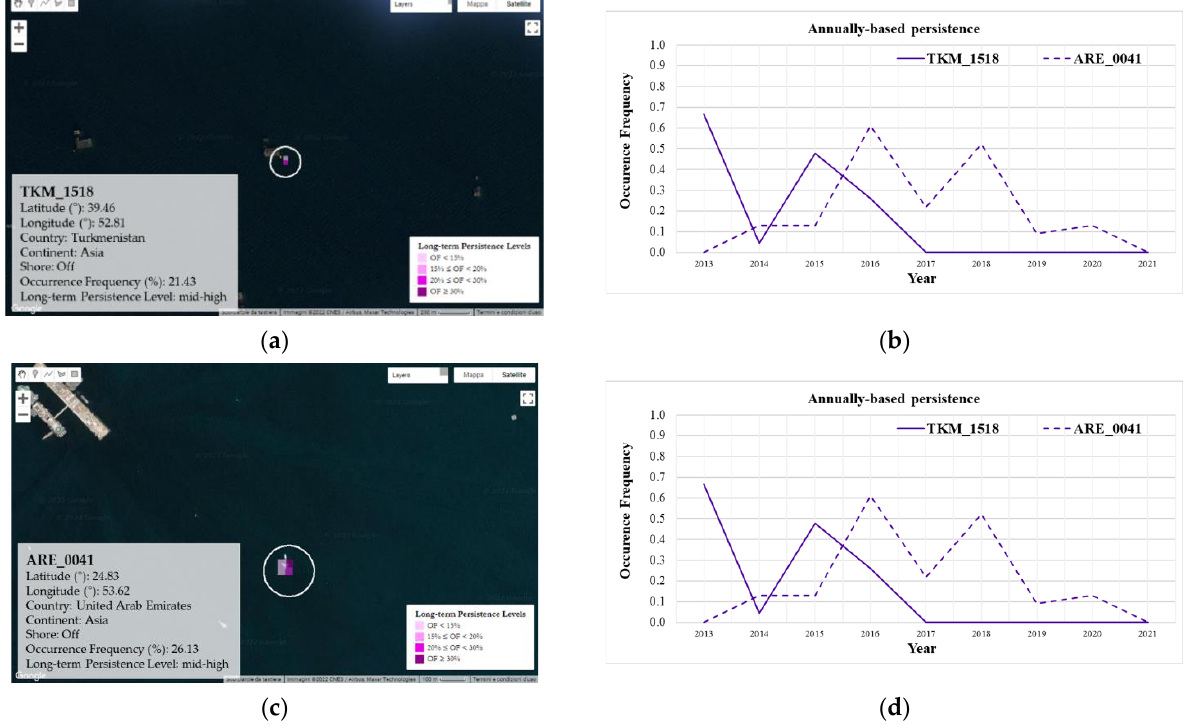
Figure 9. Features of the selected onshore GF sites, labeled as ( a ) TKM_1518 and ( c ) ARE_0041, retrieved from the DAFI GEE tool; the insets summarize the GF geographic information, along with its long-term persistence category. The ( b ) annual and ( d ) monthly temporal persistence for TKM_1518 (purple line) and ARE_0041 (purple dashed line).